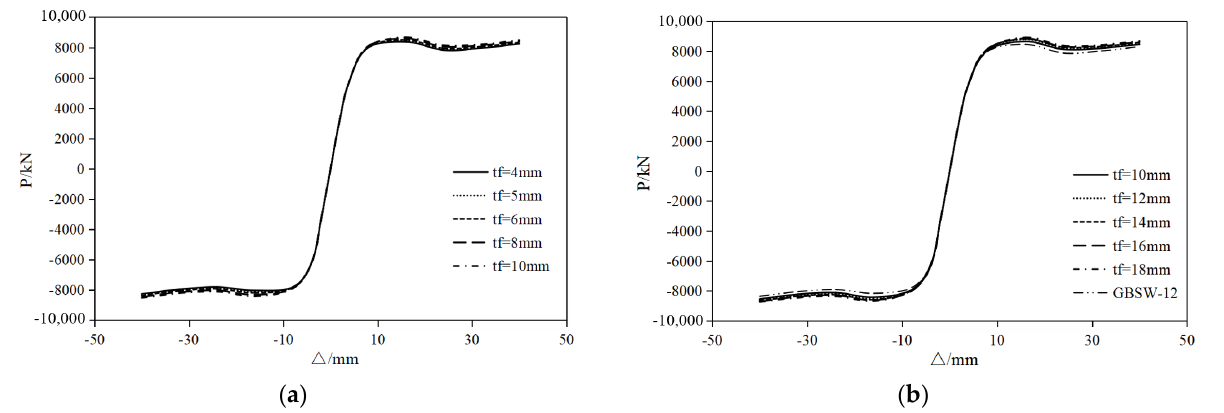
Figure 6. Skeleton curve of models with different fishplate thicknesses. ( a ) Fishplate thickness, 4~10 mm; ( b ) fishplate thickness, 10~18 mm. Table 4. Mechanical performance of models with different fishplate thicknesses. Model